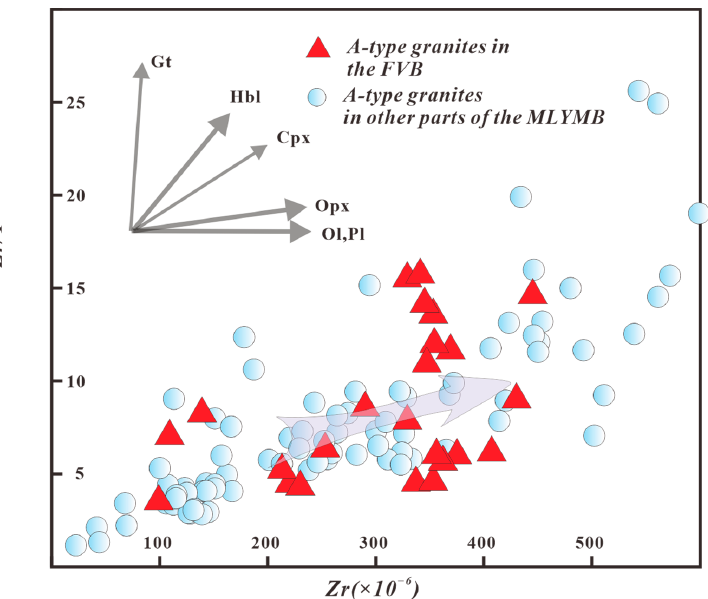
Figure 6. Zr/Y vs. Zr diagrams of A-type granite rocks in the FVB and other areas in the MLYMB